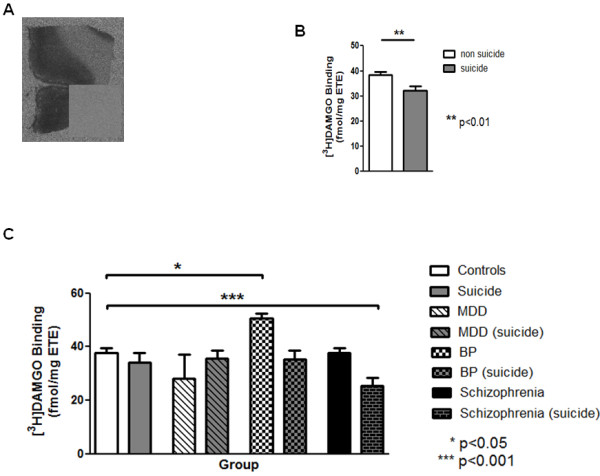
a) Representative autoradiograph of total [3 H]DAMGO binding in BA24. Insert shows non-specific binding. Results for the radioligand are represented graphically (mean ± SEM, fmole/mg ETE): b) Effect of suicide per se on levels of [3 H]DAMGO binding in BA24. c) Effect of psychiatric disorder and suicide on levels of [3 H]DAMGO binding in BA24.